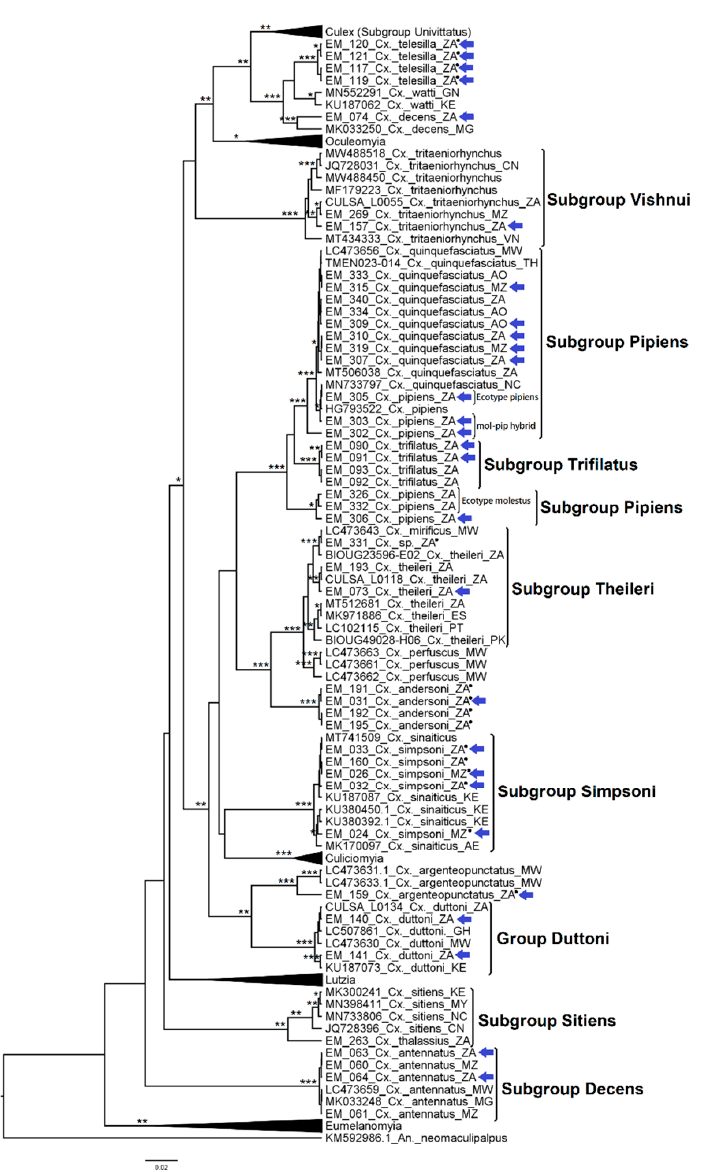
Figure 11. Phylogenetic analysis of 170 partial coxI nucleotide sequences from Culex and Lutzia mosquitoes, presenting the informal groups of the Culex subgenus. At specific branches, the number of * indicates the tree topological support revealed by the different phylogenetic reconstruction methods, assuming relevant bootstrap and aLRT values above 75% and posterior probability values above 0.80. The sequences obtained in this work are indicated by the “EM” code and those with associated genitalia are indicated by horizontal blue arrows. The sequences downloaded from GenBank and Boldsystems are indicated by their respective accession numbers and access codes (respectively); the symbol “.” after the code of our sequence indicates that said sequence was not